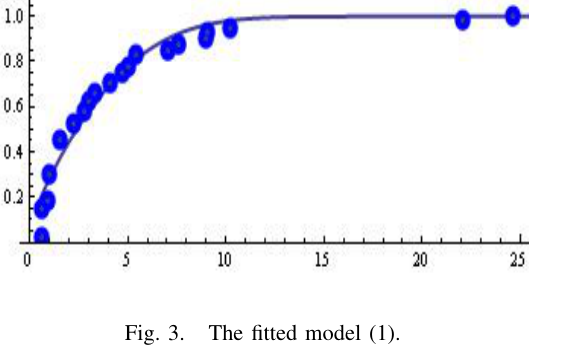
Fig. 3. The fitted model (1). Fig. 4. The fitted model (1).